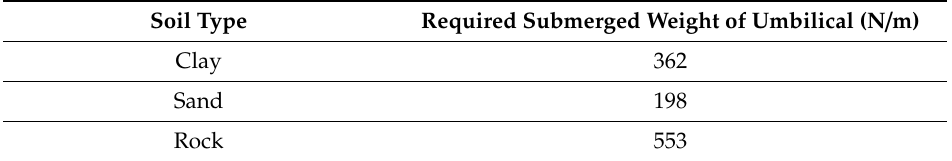
Figure 3. The lateral displacement of the umbilical for seven wave realizations and the mean and standard deviation of lateral displacement. Table 8. The required submerged